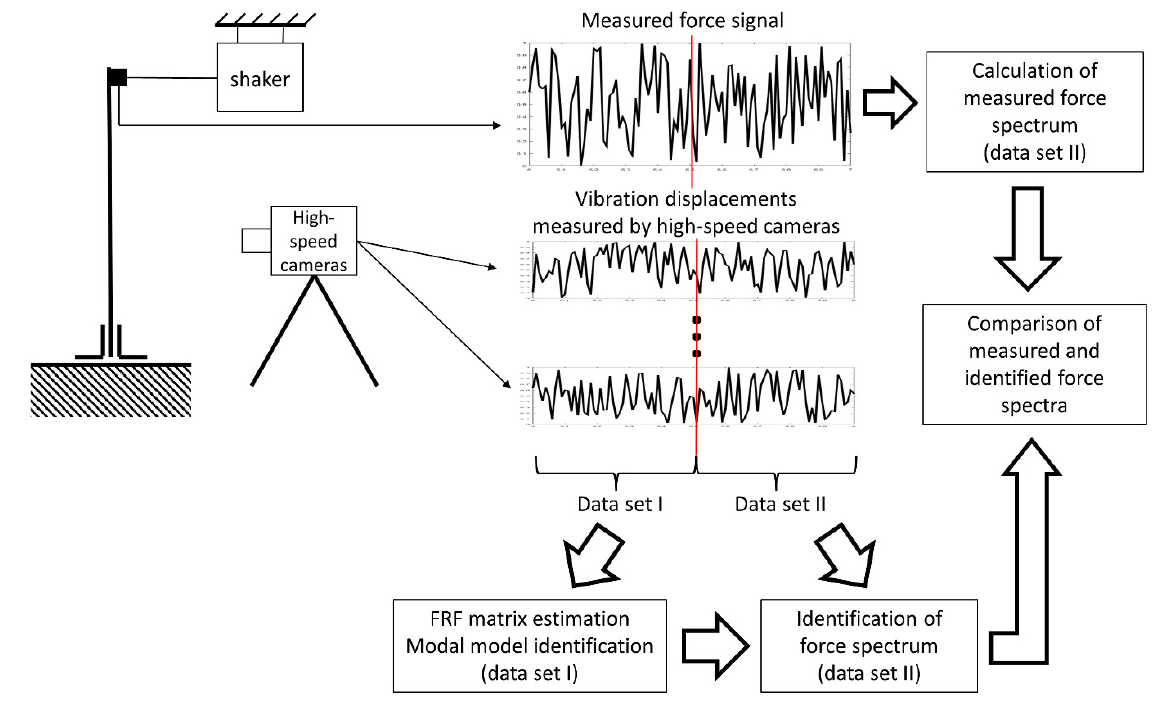
Figure 6. Experimental validation methodology.